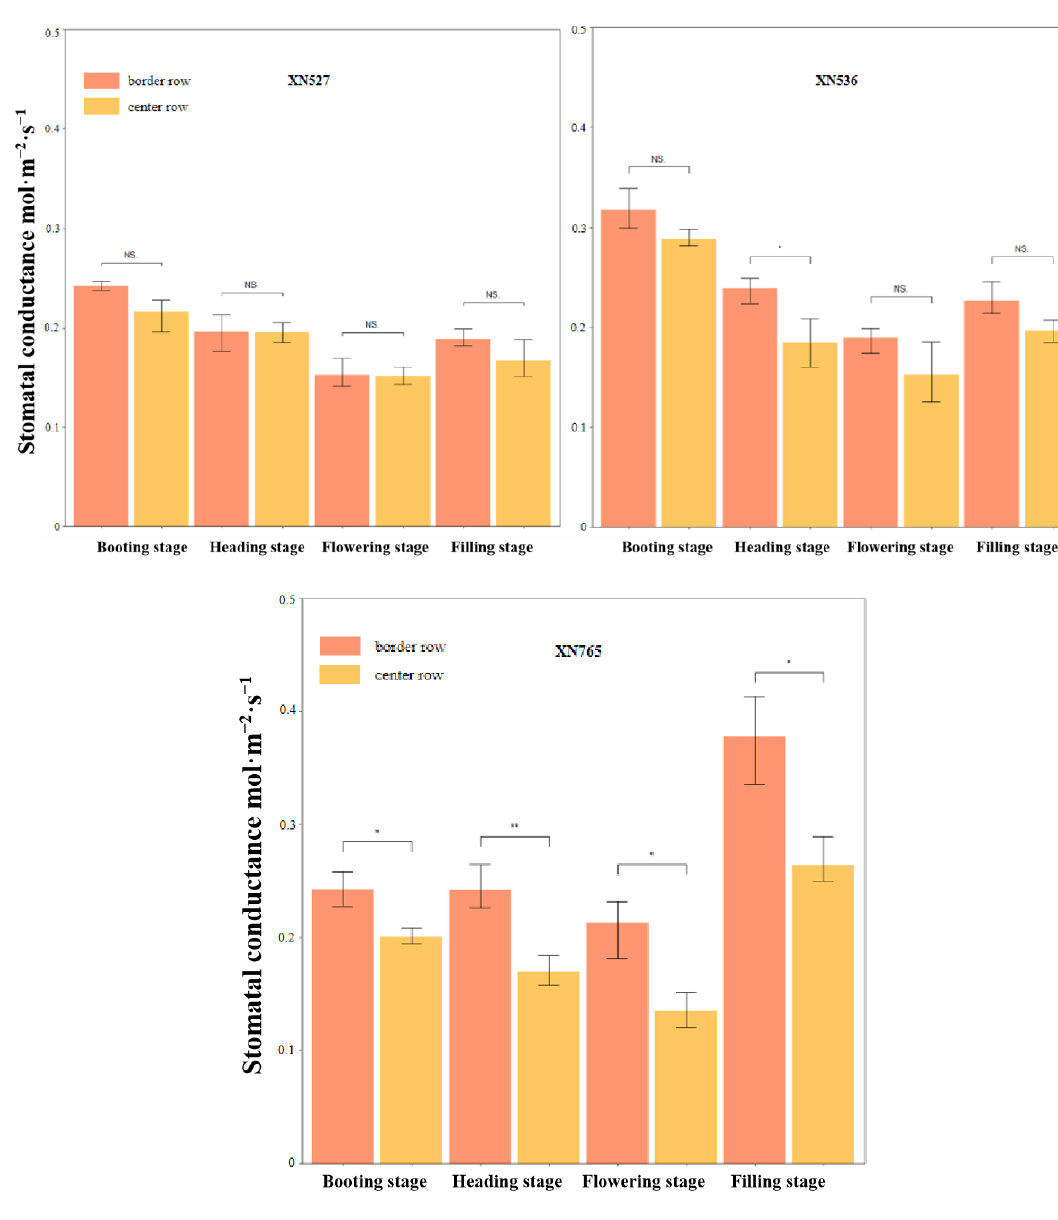
Figure 5. Border effects of stomatal conductance of wheat in different stages. (*: p ≤ 0.05, **: p ≤ 0.01, and NS: non-significant (ANOVA)).